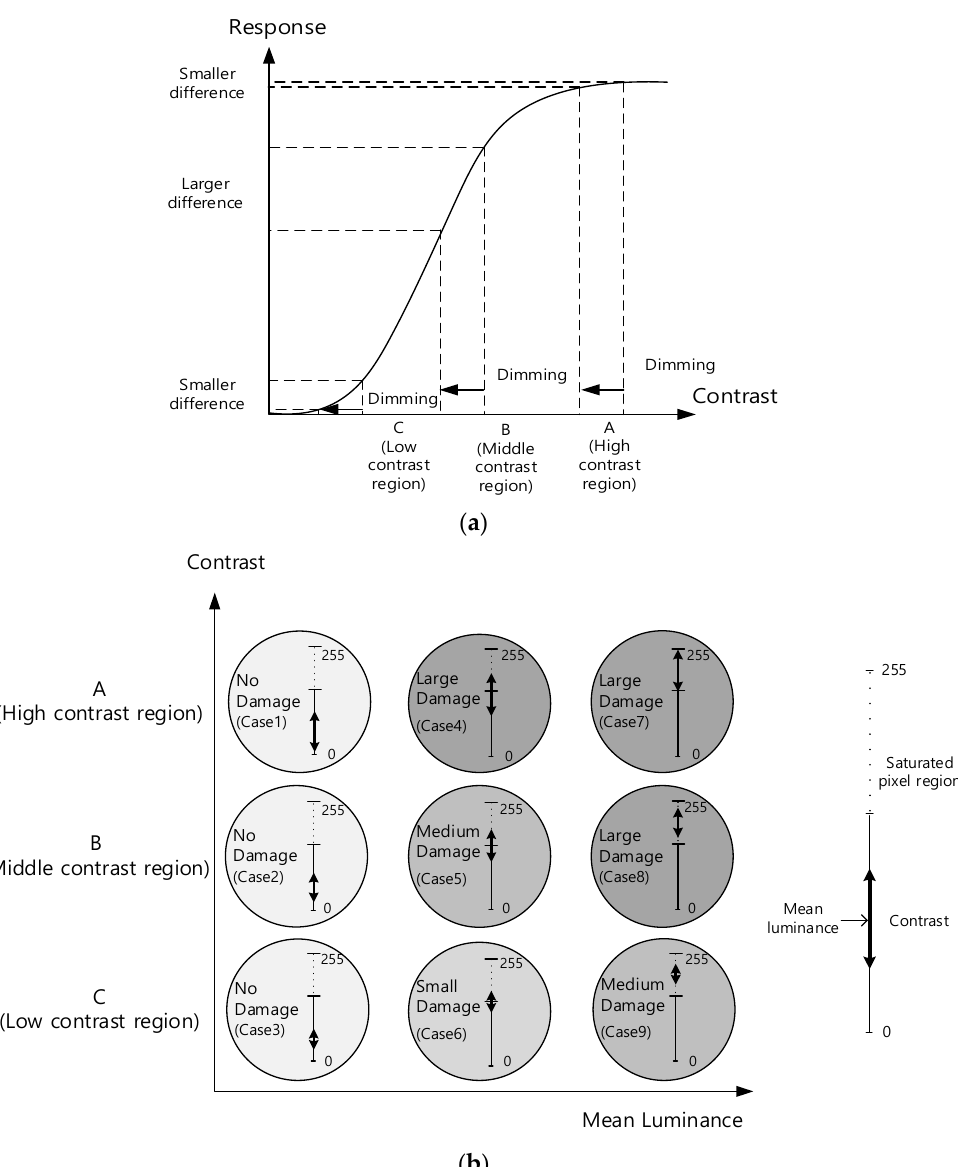
Figure 4. Contrast response function. ( a ) Contrast response function; ( b ) Nine cases of mean luminance and contrast com- binations.